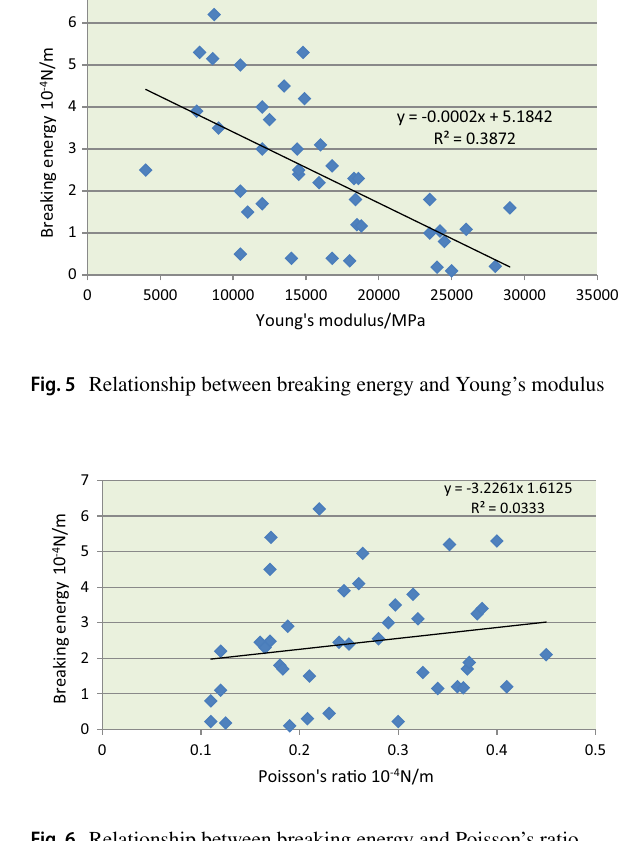
Fig. 6 Relationship between breaking energy and Poisson’s ratio